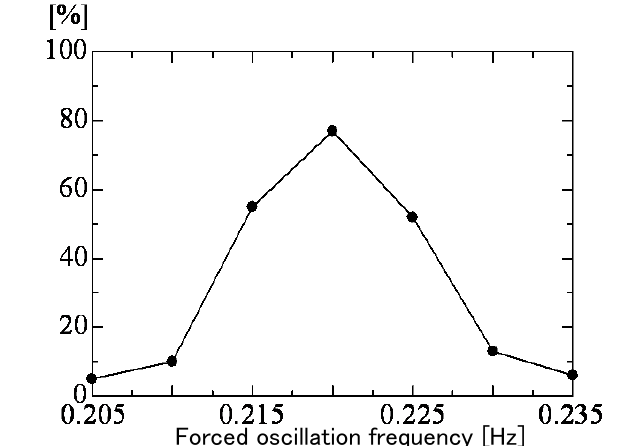
Forced oscillation frequency Fig.8 Occurrence rate of phase synchronization between forced oscillation frequency and vortex shedding frequency